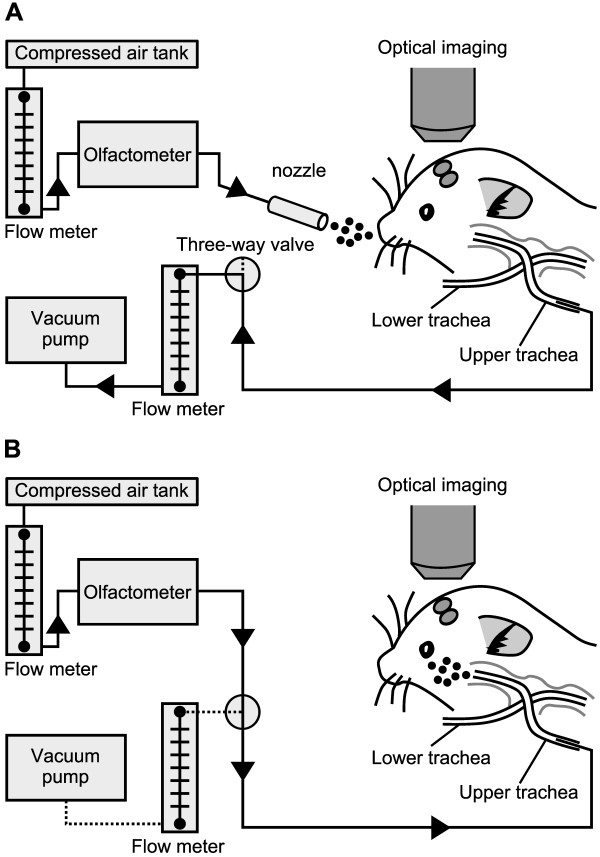
Schematic diagrams of the odor presentation system. A: Experimental set-up for orthonasal odor presentation. The olfactometer was connected to an odor nozzle and presented odor stimuli to the mouse’s nose. The upper cannula was connected to a flow meter and a vacuum pump, which controlled nasal airflow rates. The lower cannula accessed the lower trachea and remained open for normal breathing. B: Experimenatal set-up for retronasal odor presentation. The olfactometer was connected to a three-way valve and presented odor stimuli through the upper cannula. Our set-up permitted reciprocal switching of orthonasal and retronasal delivery modes in the same animal.